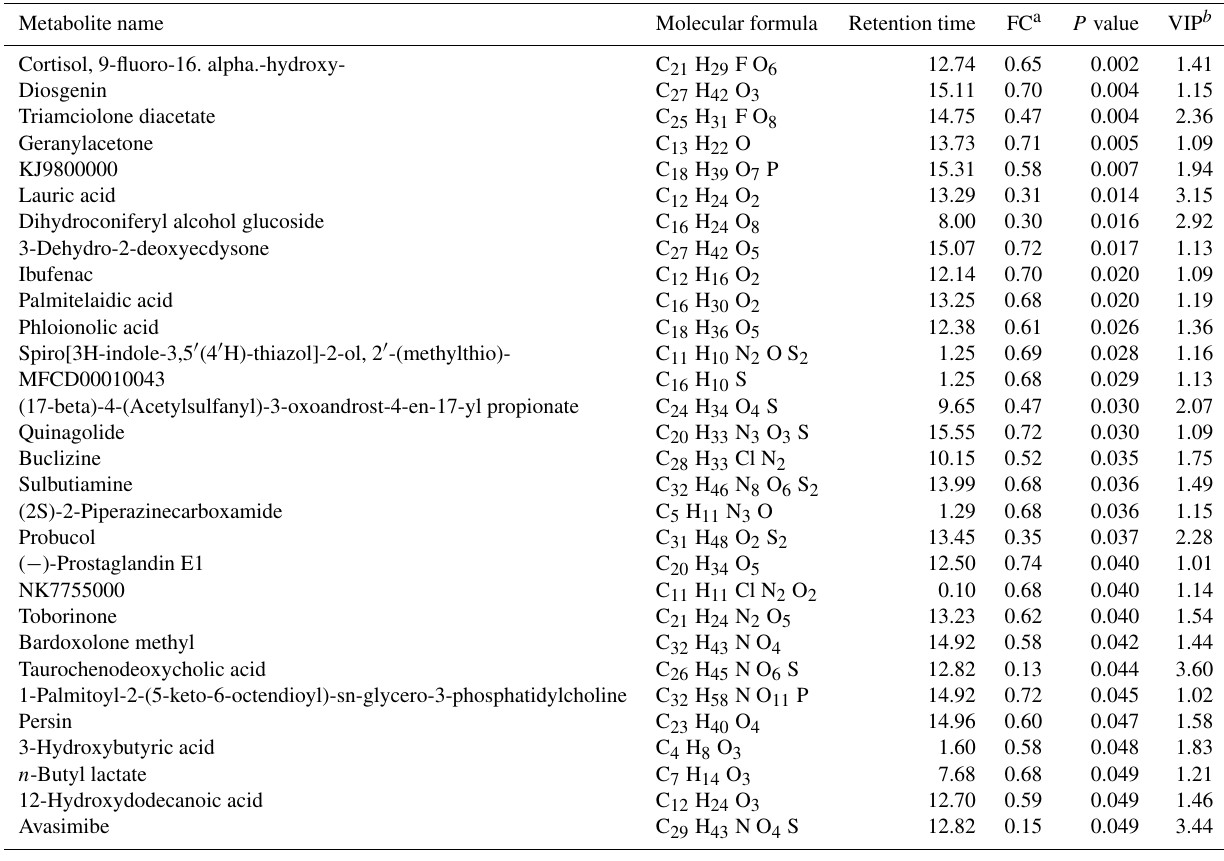
Table 2. Decreased metabolites for the agomiR-499-treated group compared with the control. Metabolite name Molecular